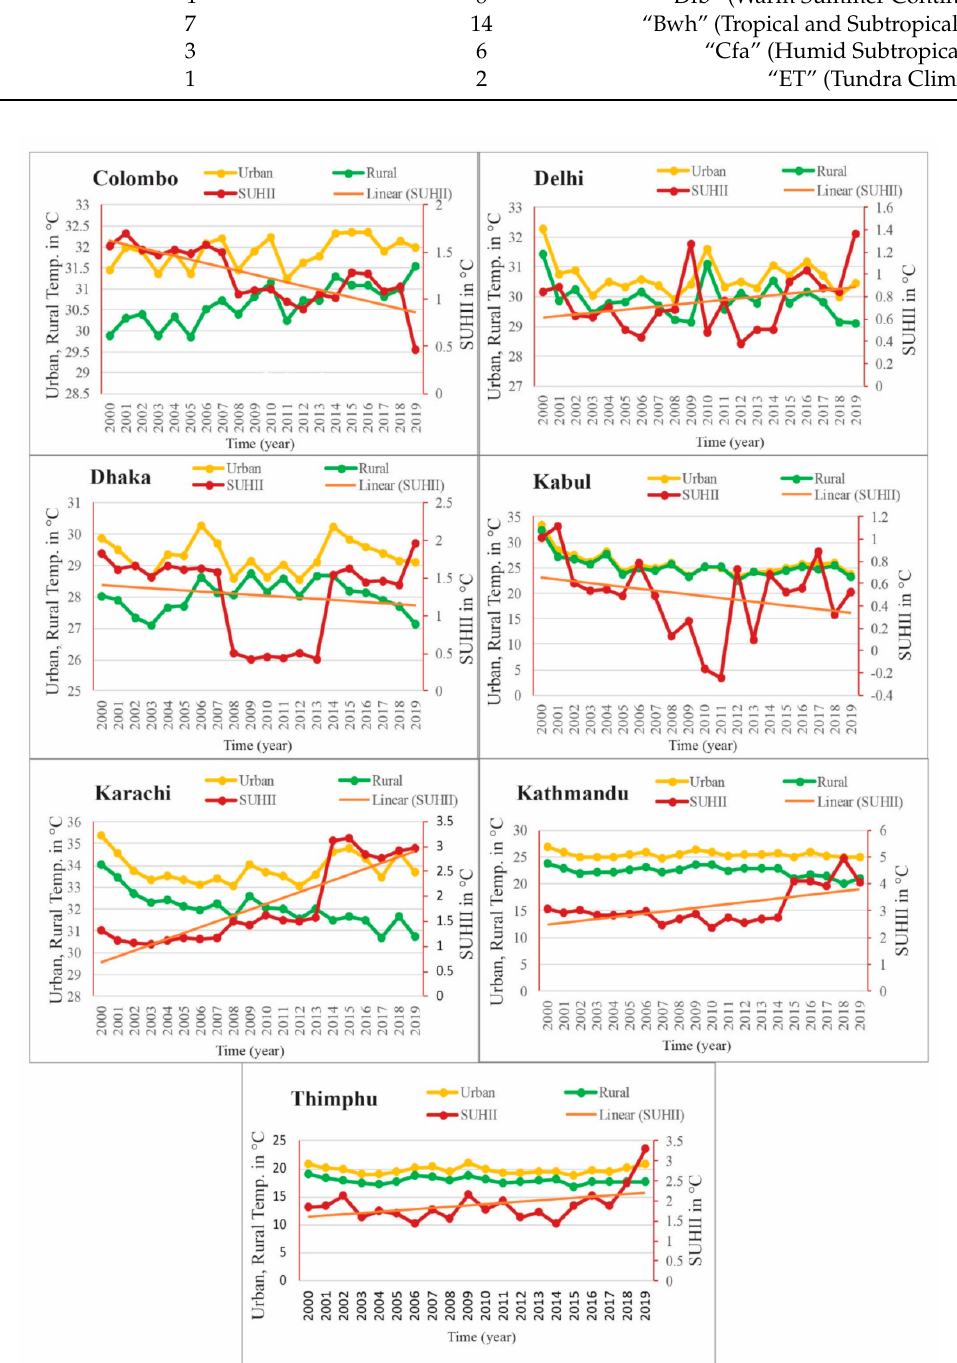
Figure 5. SUHII Trends for SA Cities for 20